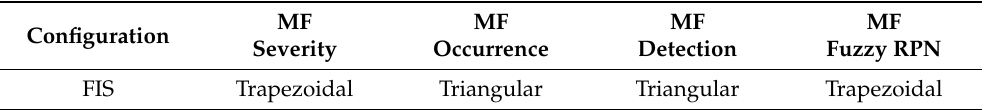
Table 9. Membership functions for the tested FIS